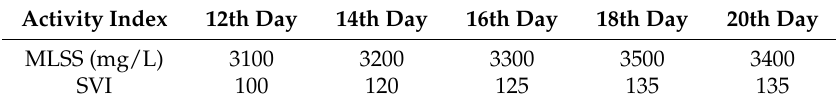
Figure 5. ABS system structure. Table 4. ABS system activity index.